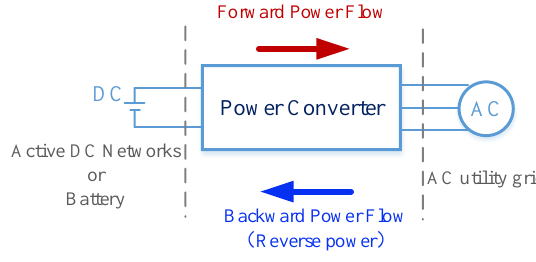
Figure 1. Bidirectional DC/AC converter.